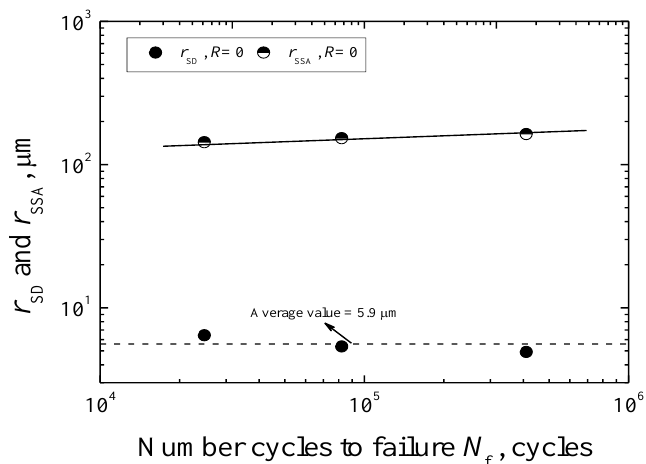
Figure 7. Relationships between radius of surface defect ( r SD ), radius of surface smooth area ( r SSA ), and fatigue life ( N f ). and fatigue life ( N f ).